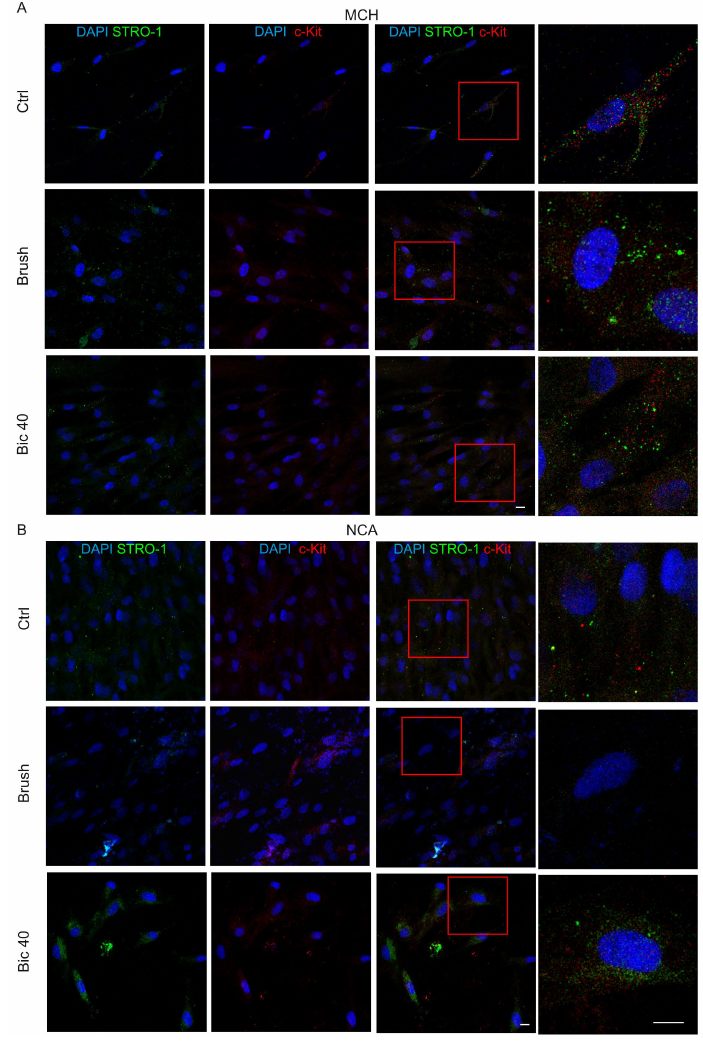
Figure 5. Evaluation of stemness markers of hDPSCs on titanium surfaces after cleaning treatments. Immunofluorescence analysis of STRO-1 and c-Kit in hDPSCs cultured for 7 days on MCH ( A ) and NCA ( B ) surfaces from the three experimental groups. Red squares indicate details reported at higher magnifications on the right. Nuclei were stained with DAPI. Scale bar: 10 µ